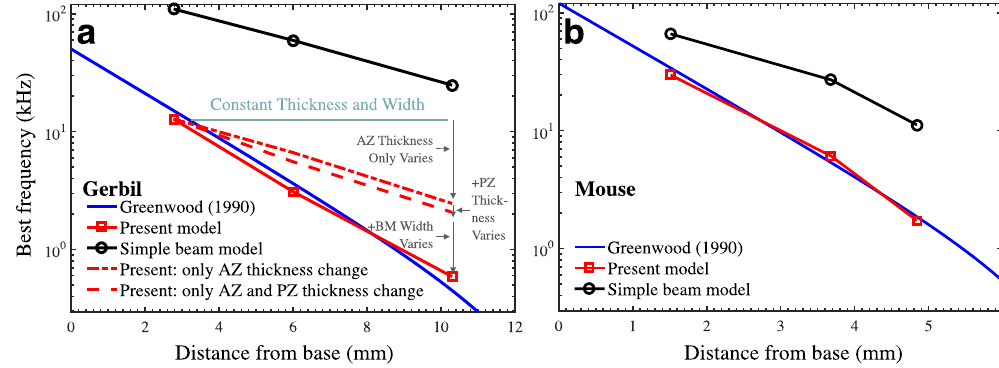
Figure 5. ( a ) Comparison of the predicted frequency–place cochlear map of the gerbil cochlea from the ABM (solid red line; using the model in Fig. 1d) and SBM (solid black line) under pressure loading. Also shown is the Greenwood cochlear map 29 (blue line). The red dash-dotted line shows the effects of varying only the AZ fiber-layer thickness longitudinally with position in the ABM. The red dashed line shows the effects of varying the thickness of both the AZ and PZ fiber layers longitudinally with position. For the solid red (ABM) and black (SBM) lines, both the BM fiber-layer width and thickness vary longitudinally with position. Since the AZ width is proportional to the total width, the difference between red solid and dash-dotted lines is due primarily to the AZ width variation. ( b ) Comparison of the SBM and ABM for the mouse cochlea to the corresponding Greenwood cochlear map (blue